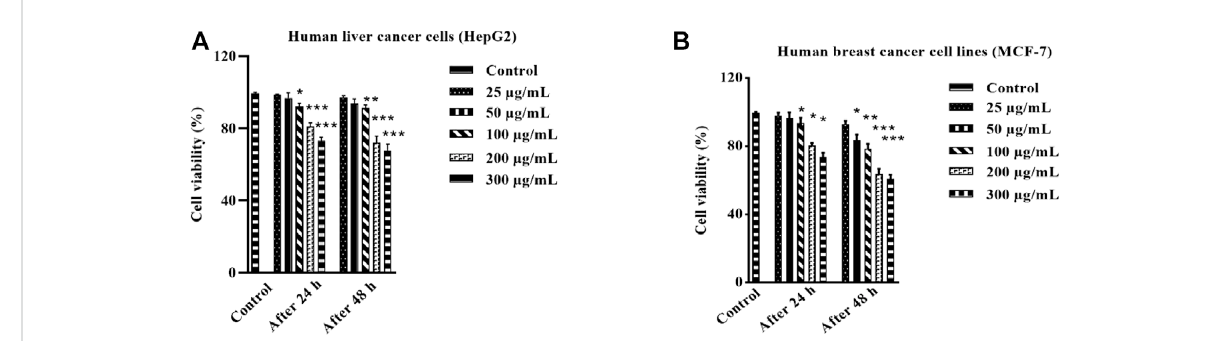
FIGURE 5 AnticancereffectofHAECAonhumanlivercancercells (A) andcellviability(%)againsthumanbreastcancercells (B) .Allvaluesareexpressedas mean ± SD ( n =